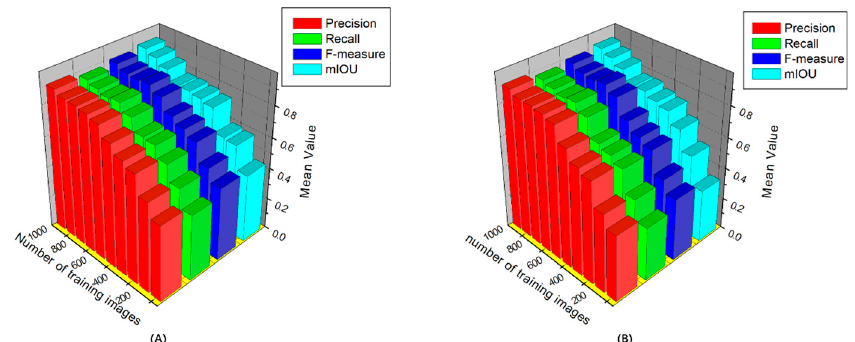
Figure 6. Detection performance with and without transfer learning for different numbers of trainings: ( A ) with transfer learning, ( B ) without transfer learning.